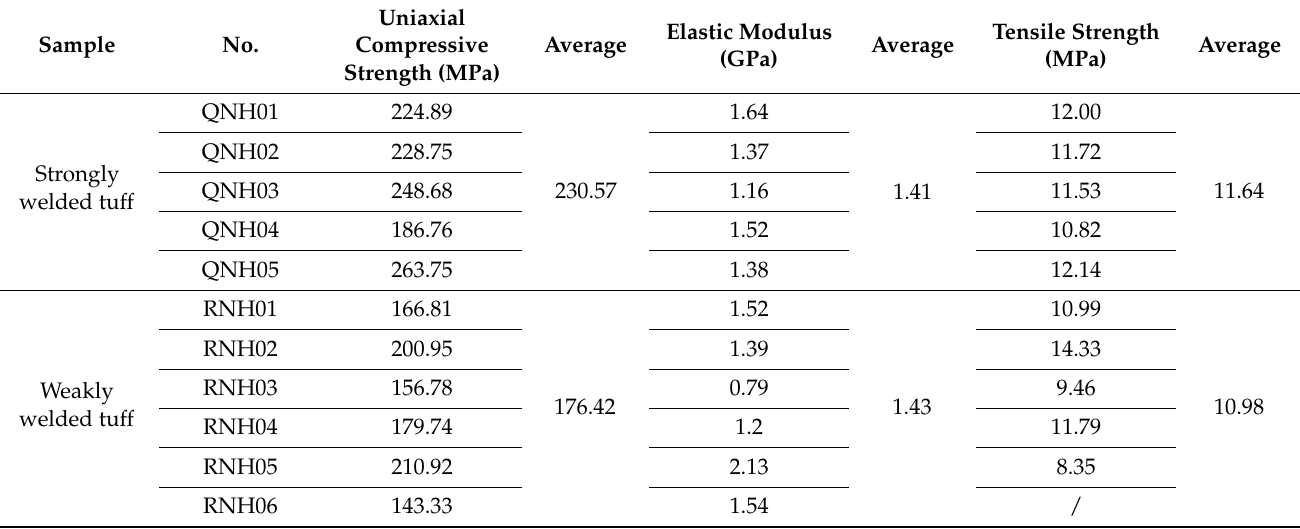
Table 2. The results of the mechanical properties of the different welded